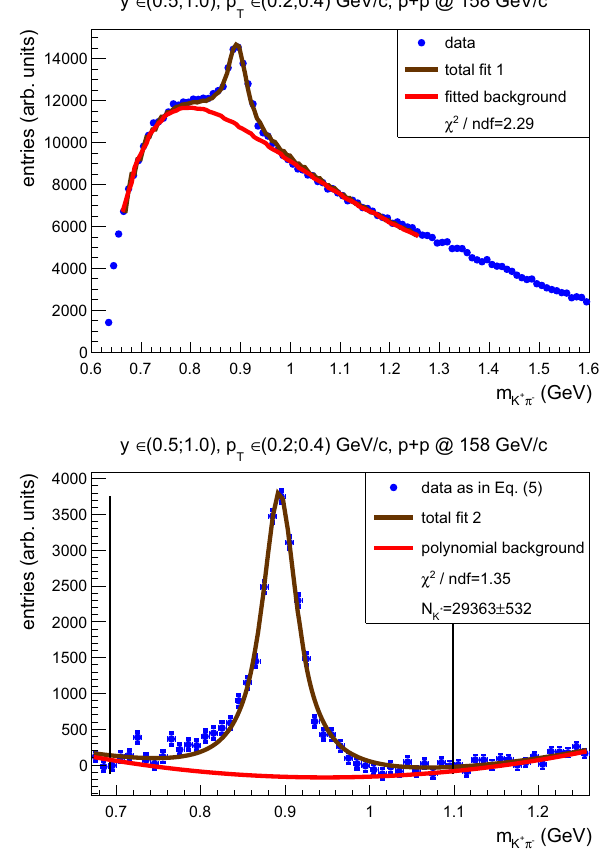
(blue points), and fitted background (red line) obtained from the tem- plates. Bottom: background subtracted signal for the standard method (left) and template method (right) – more details in the text. Thin black vertical lines in bottom right panel correspond to the range of integrat- ing fit functions while obtaining the raw number of K ∗ ( 892 ) 0 mesons ( m 0 ± 4 (cid:4) 0 ; see the text for details)